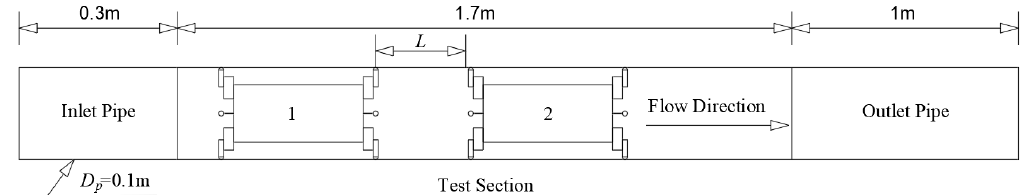
Figure 1. Schematic of horizontal pipe section. Note: 1 and 2 represent the pipe vehicles. L represents the vehicle spacing; the value of L in this simulation is 0.5 l / l / 1.5 l / 2 l / 2.5 l / 3 l / 4 l.